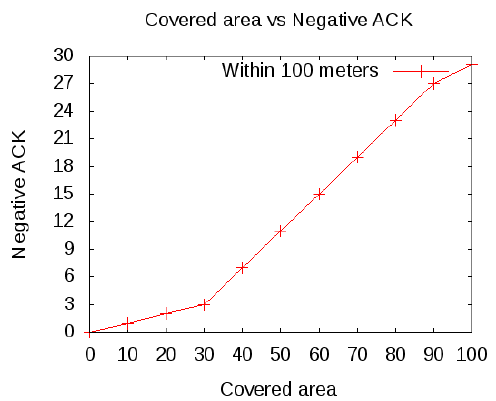
Figure 4. Negative ACK due to presence of spoofing attack.